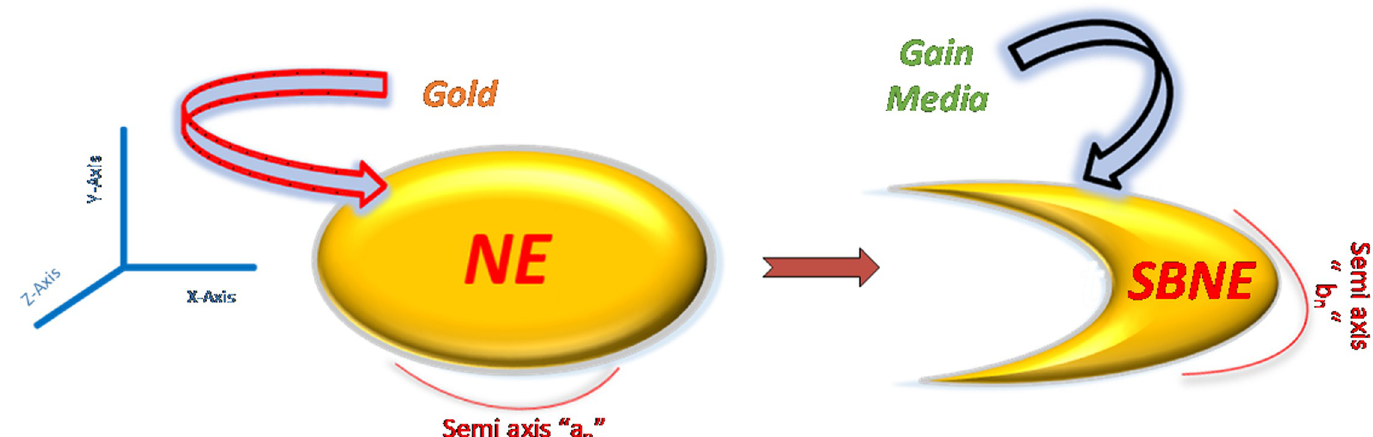
Fig 1. The transformation from single nano-ellipse (NE) to symmetry broken nano-ellipse (SBNE).